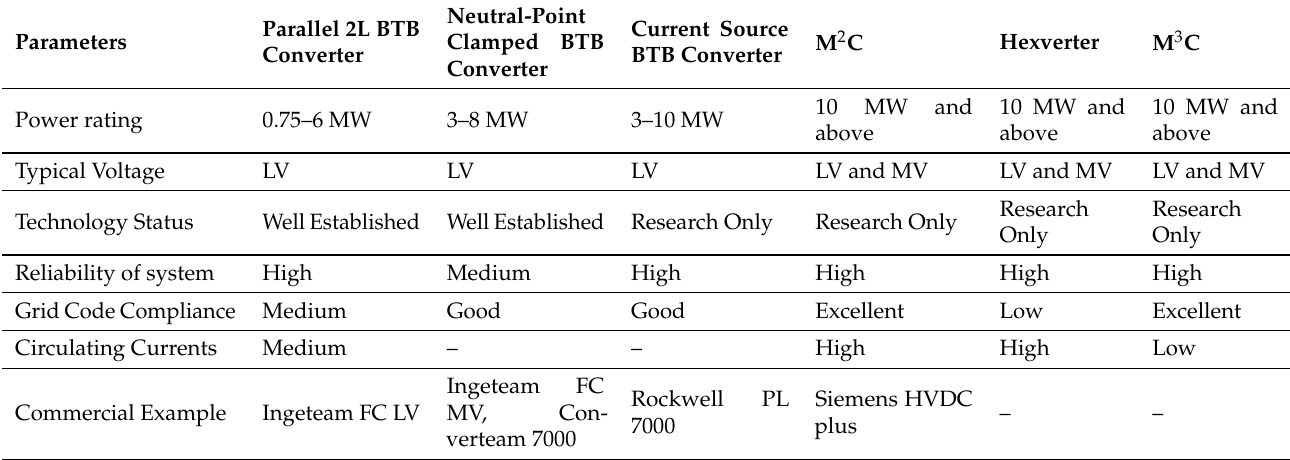
Table 6. Comparison of different power converter topologies for